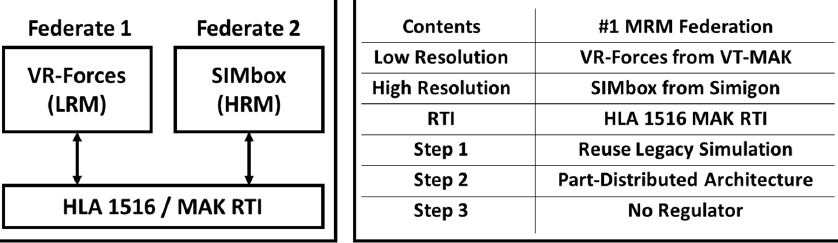
Figure 23. MRM federation configuration.